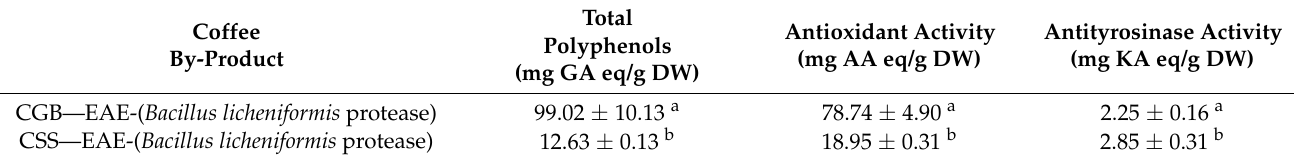
Table 4. Antioxidant, antityrosinase, and antimicrobial activities of CGB Bacillus licheniformis protease extract (equal letters = statistically equal data, p < 0.05, Kruskal–Wallis test). Different letters (a and b) in the same column mean statistically different values.